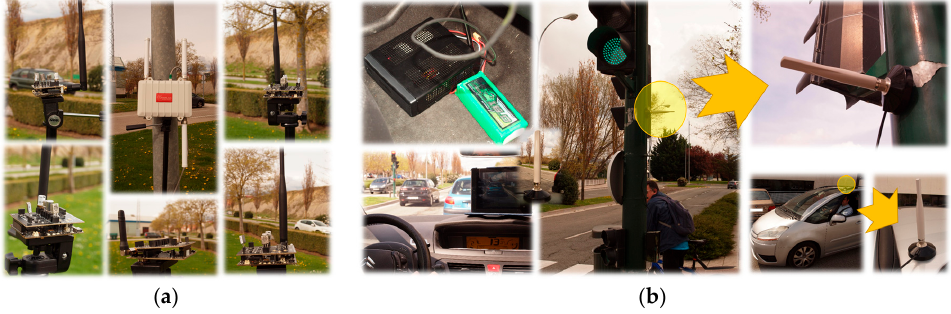
Figure 9. Different devices employed in order to implement the VANET WSN testbed: ( a ) infrastructure gateways and motes; and ( b ) embarked transceivers.